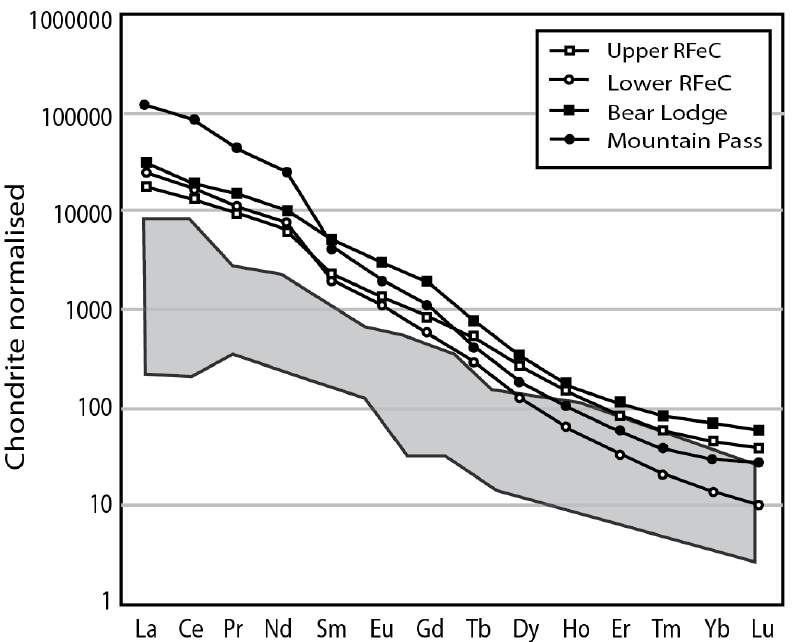
Figure 10. Comparison of the average REE patterns within the upper portion of the REE-rich Fe-carbonatite (Upper RFeC–open squares), the lower portion of the REE-rich Fe-carbonatite (Lower RFeC–open circles), standard carbonatite ([10]–grey zone), magmatic mineralization from Mountain Pass samples ([77]–closed circles) and hydrothermal mineralization from Bear Lodge samples ([59]–closed squares). Chondrite data from McDonough and Sun [61].